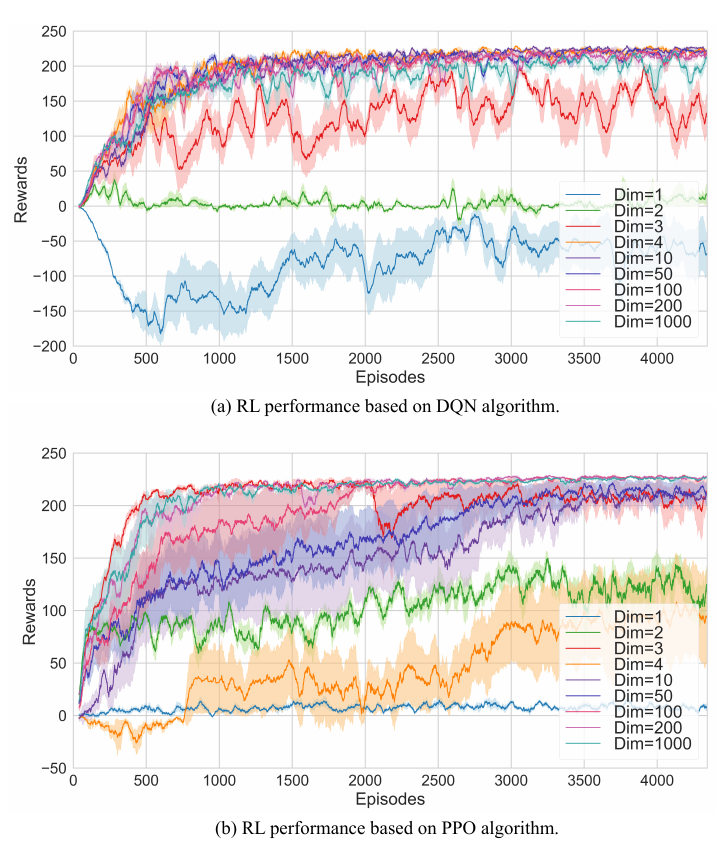
Figure 8. Performance (mean and standard error for 5 runs) of DQN and PPO algorithms with state representations learned from different embedded dimension in mobile robot 2D navigation environment. Table 4. The influence of the embedded dimension in Mobile Robot environment. The average total reward is calculated among the last 100 episodes of 10 6 training